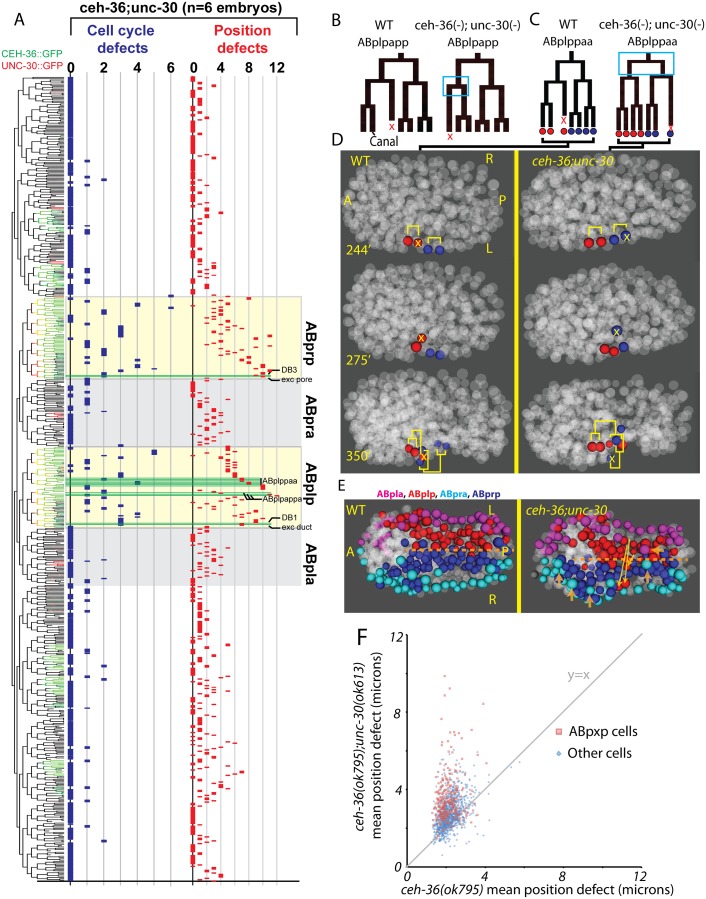
unc-30;ceh-36 double mutant lineage phenotypes.A) Frequency of defects in each cell of unc-30;ceh-36 double mutants (compare to Fig. 4). Expression tree shows CEH-36::GFP (Green) and UNC-30::GFP (Red). B-D) Examples of “lineage reversals” where the division patterns of daughters of ABplpappa (B) or ABplppaa (C) reverse their patterns of division and death and migration (D). E) Positions of ABpxp (express ceh-36 and unc-30) and ABpxa (express neither ceh-36 nor unc-30) derived cells in the wild type model and a unc-30;ceh-36 double mutant embryo showing ABpxp-derived cells that have crossed the midline (yellow arrows show deviation from wild-type mean position) and incomplete migration of ventral epidermal cells (derived from ABpxa) (orange arrows). F) Mean magnitude of position defects in ceh-36 and double mutants.